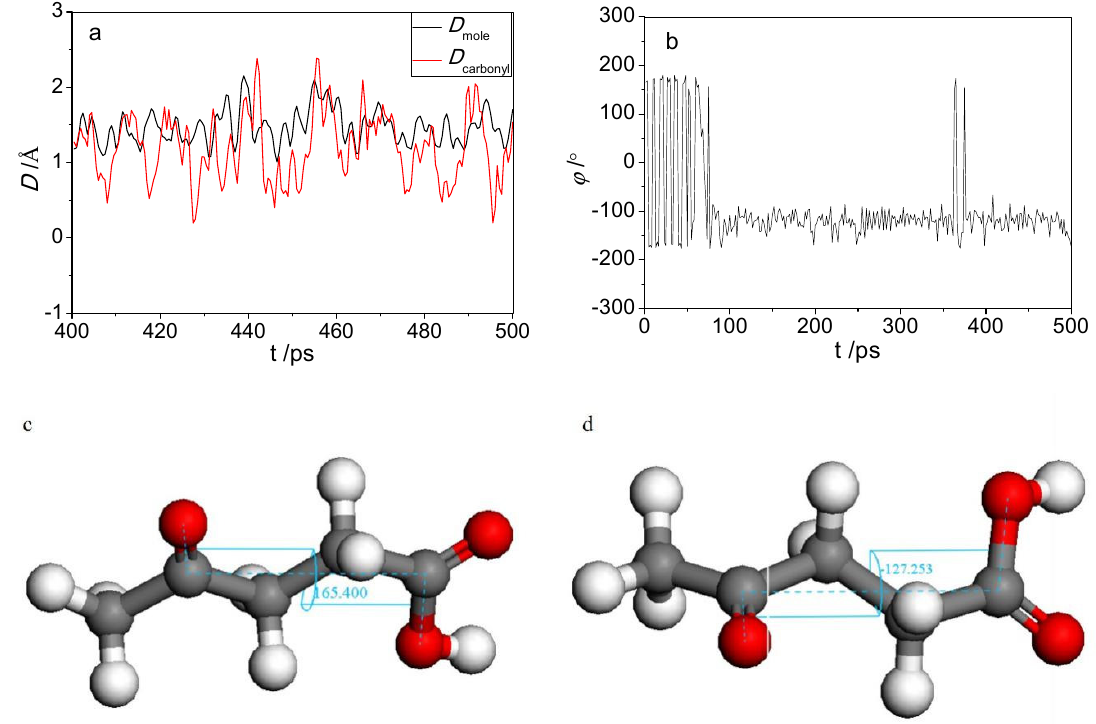
Figure 5. ( a ) Distance of the carbonyl group and the molecular centroid from the cellulose surface varies over time; ( b ) Dihedral angle between the carbonyl group and the carboxyl group varies over time; ( c ) Dihedral angles of carbonyl and carboxyl groups before adsorption; ( d ) Dihedral angles of carbonyl and carboxyl groups after adsorption.